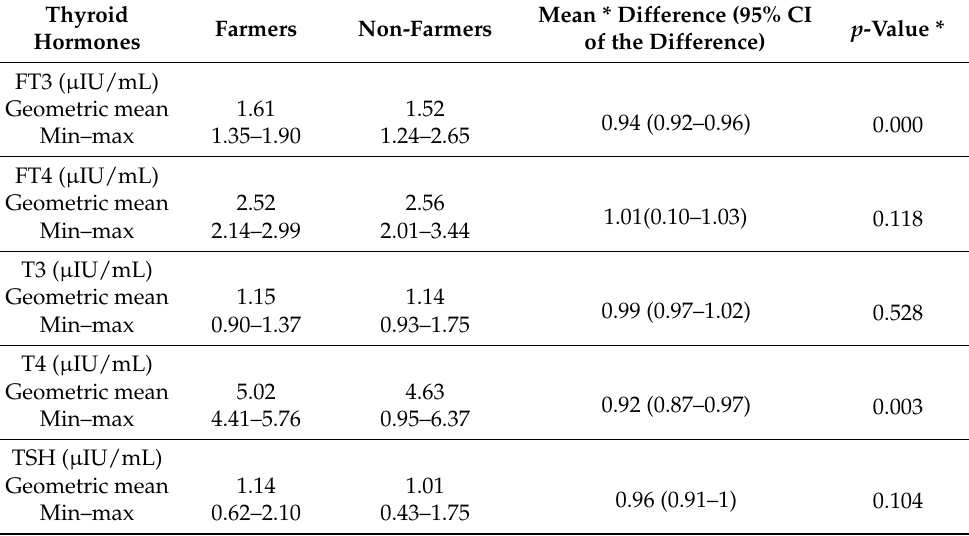
Table 3. Thyroid hormones for farmers ( n = 127) and non-farmers ( n =